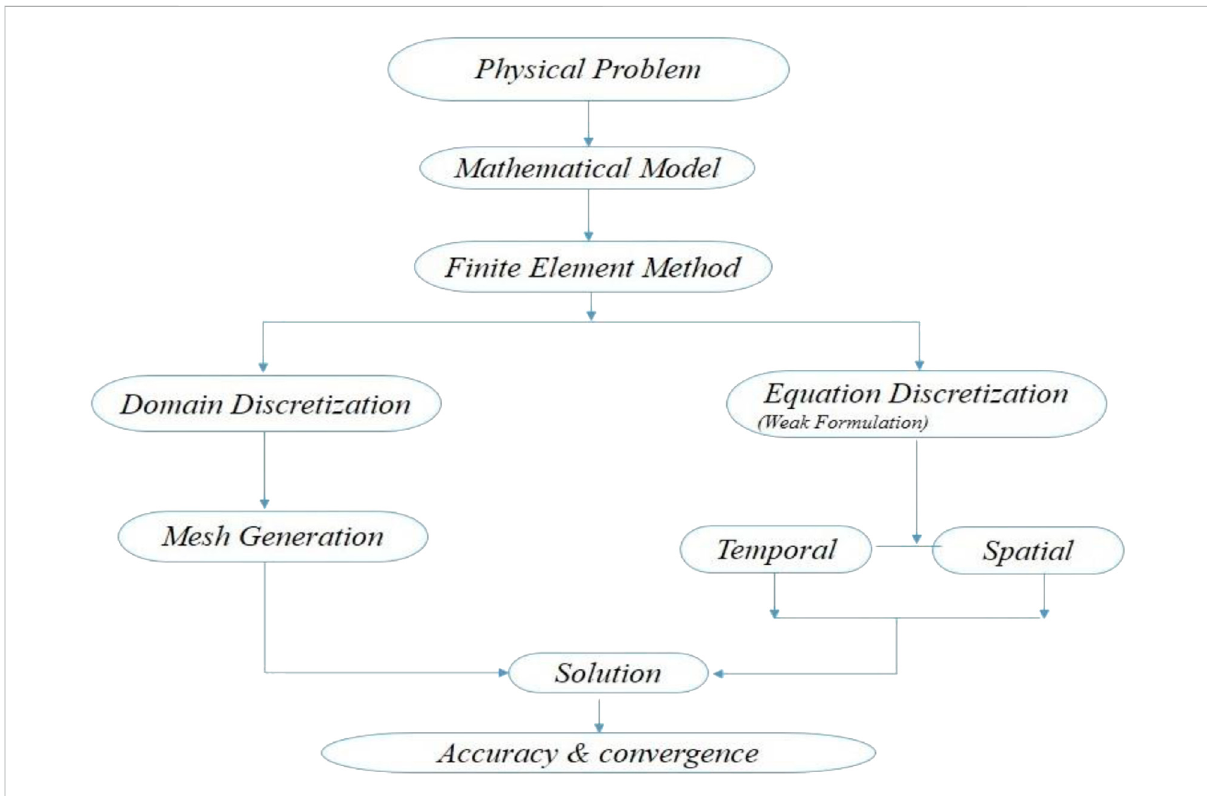
FIGURE 3 Representation of steps in the computational